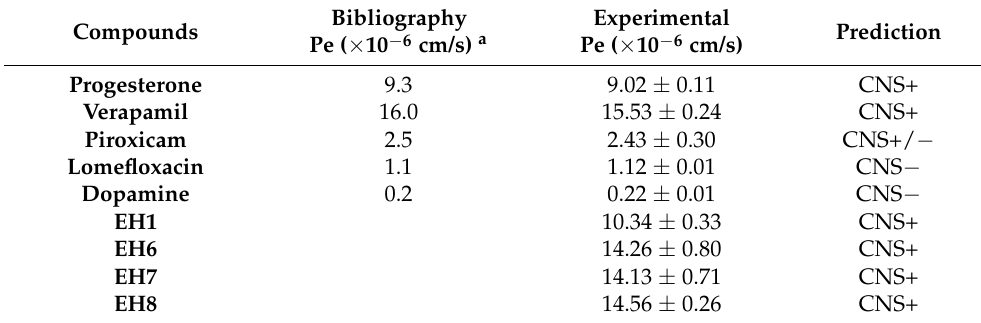
Table 2. BBB assay of standard and EH compounds.